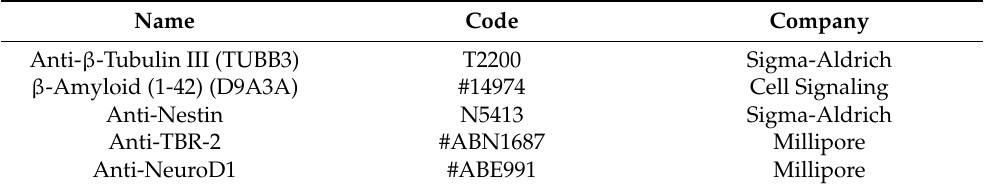
Table 3. Primary antibodies used for immunohistochemistry